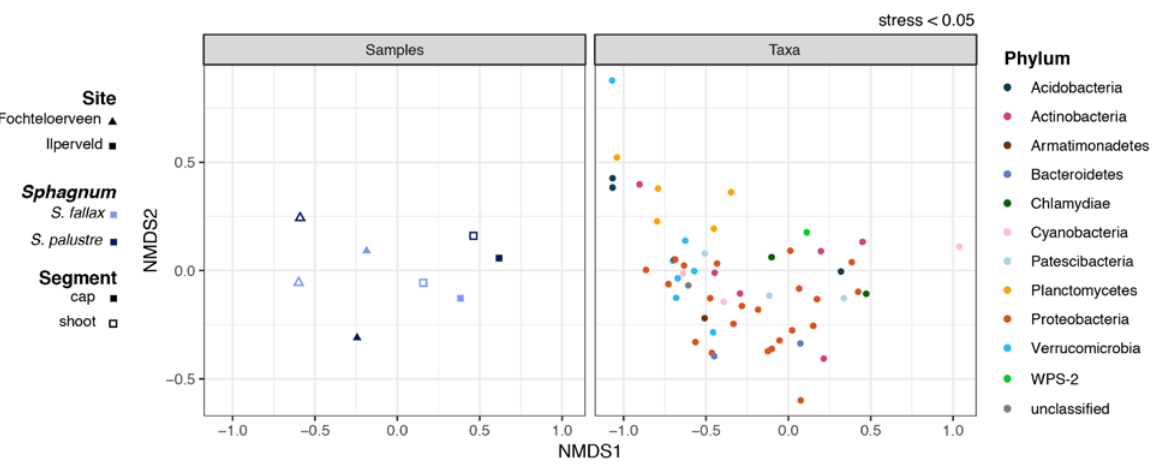
Figure 5. Split plot of the NMDS ordination (based on Bray-Curtis dissimilarity matrix; stress <0.05) of the samples (left) and the corresponding taxa at phylum level